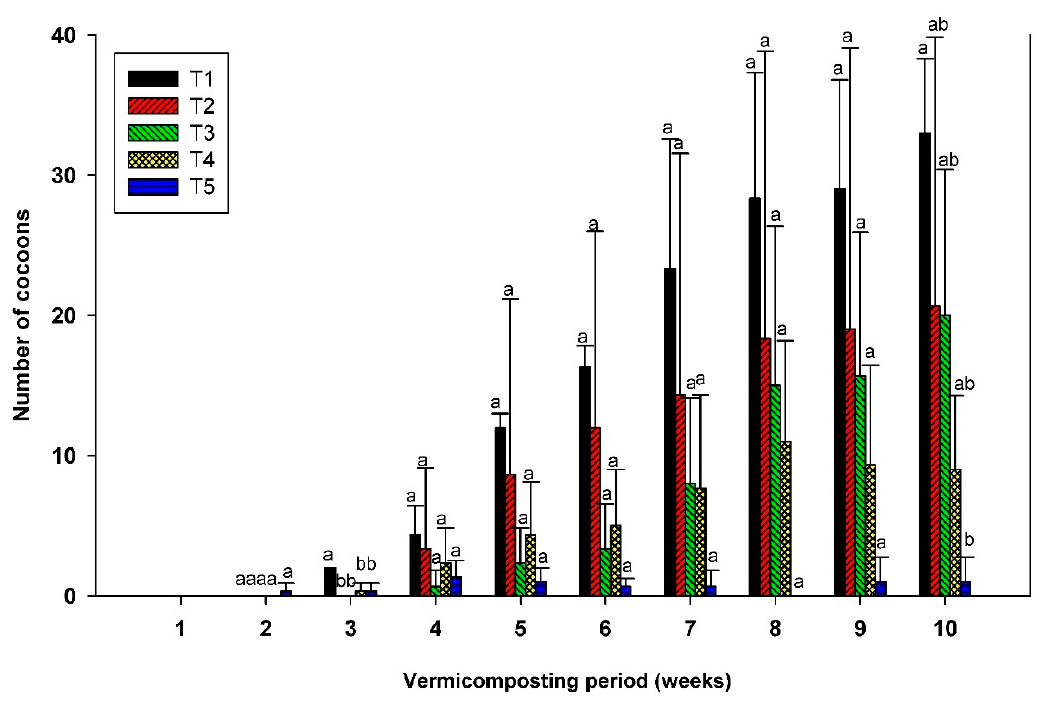
Figure 3. Mean values of the number of the cocoons produced by the earthworms followed by different letters in the same week are different in terms of statistical significance ( p -value < 0.05) between the combinations involved.